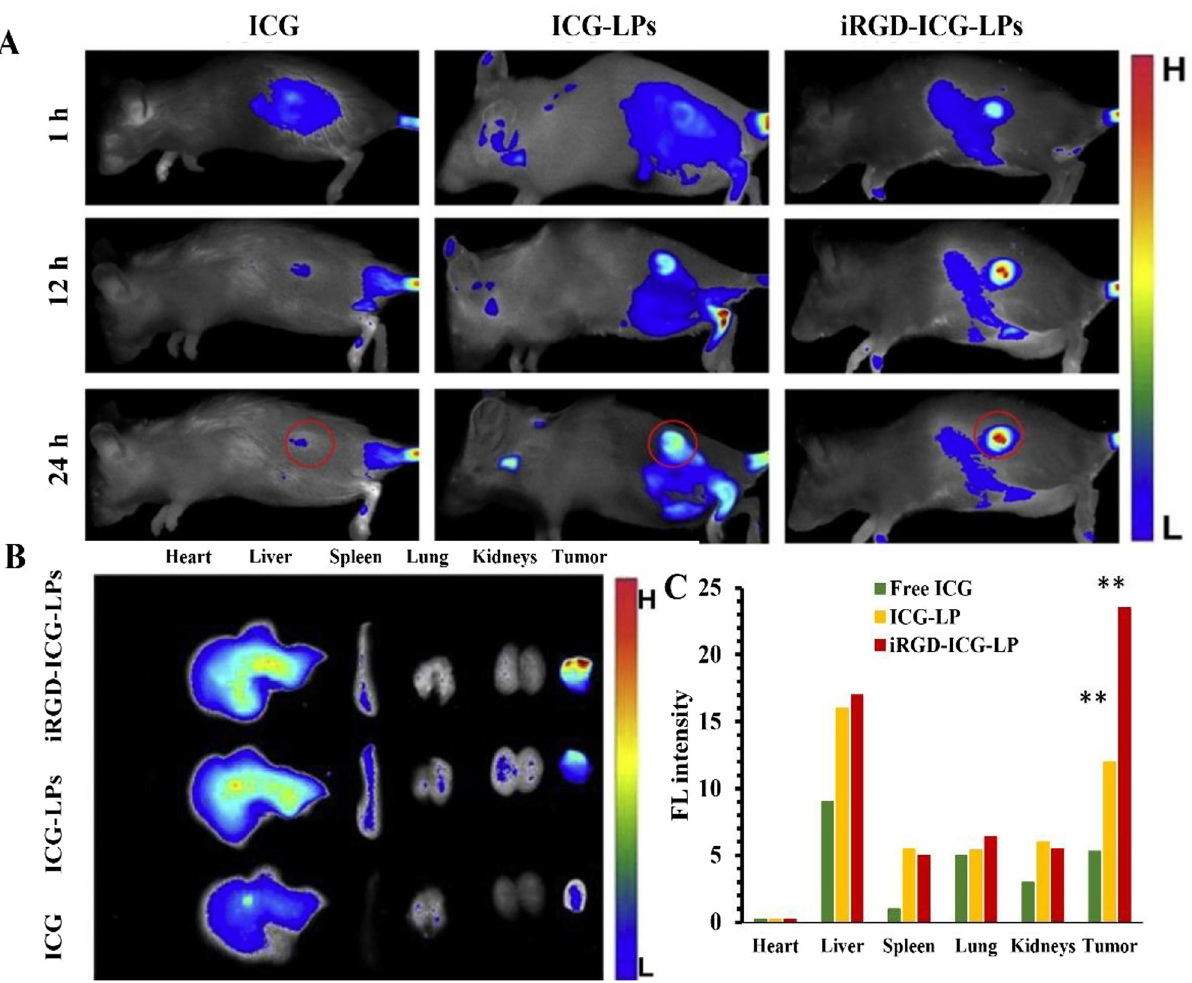
Figure 18: In vivo molecular imaging and biodistribution. ThefreeICG,ICG-LPs,oriRGD-ICG-LPswereIVadministratedtothe4T1tumor-bearingmiceandthetumorsandmajororganswereimagedwith the ex / invivo imagingsystem.(A)Fluorescencesignalwasobtainedintumorsitesat1,12,and24hafterIVadministrationoffreeICG,ICG-LPs, or iRGD – ICG-LPs with 0.5 mg/kg equivalent ICG. (B) Ex vivo fl uorescence images of major organs and tumors were obtained at 24 h post injection of free ICG, ICG-LPs, or iRGD-ICG-LPs with 0.5 mg/kg equivalent ICG. (C) Semiquantitative analysis of fl uorescence intensity for